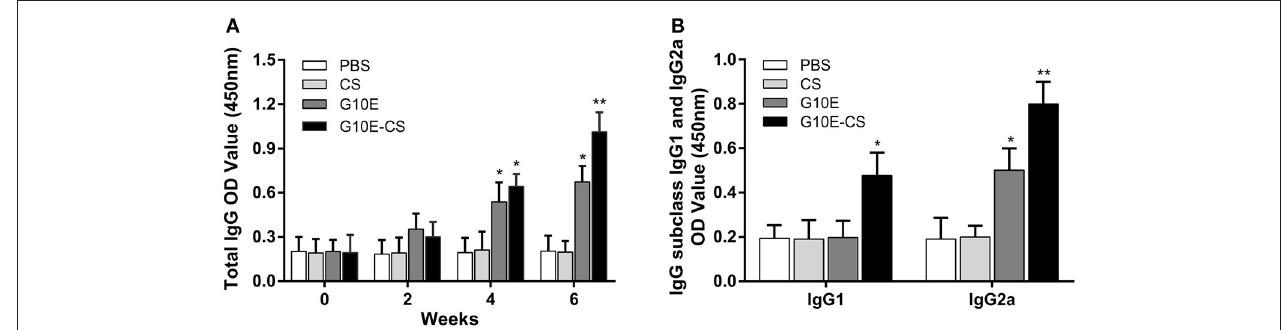
FIGURE 4 | Humoral immune response induced in BALB/C mice after vaccination with G10E-CS. (A) Detection of total anti-GRA10 IgG antibody in the sera of immunized BALB/C mice. The mice were immunized intramuscular injection three times at 2 weeks interval with G10E, CS, G10E-CS, or PBS. Sera were collected from mice by retro-orbital bleeding at 0, 2, 4, and 6 weeks after immunization. The levels of T. gondii -specific IgG antibody in the sera of samples was used to determine by ELISA assay. (B) Detection of IgG subclass IgG1 and IgG2a antibodies in the sera of the immunized mice. Sera were collected at 2 weeks after the last vaccination. The level of IgG1 and IgG2a antibodies were measured by ELISA. Results are expressed as the mean of OD450 ± SD ( n = 15) and are representative of at least three independent experiments. * p < 0.05, ** p <